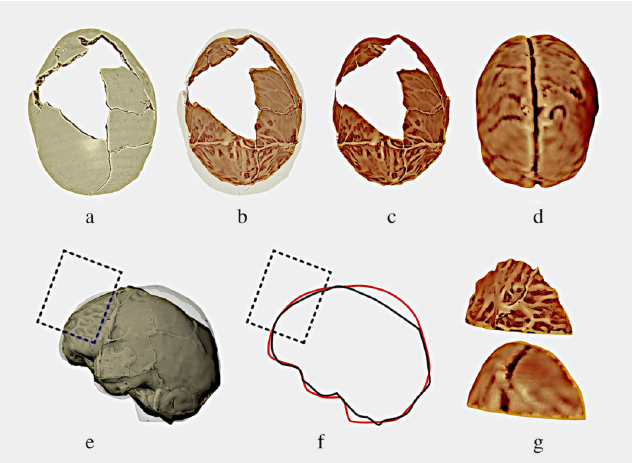
Fig 3. a-g. Brain endocast reconstruction and volume of the brain including the meninges. The area of the frontal lobe affected by the pathological process is indicated by a rectangle.